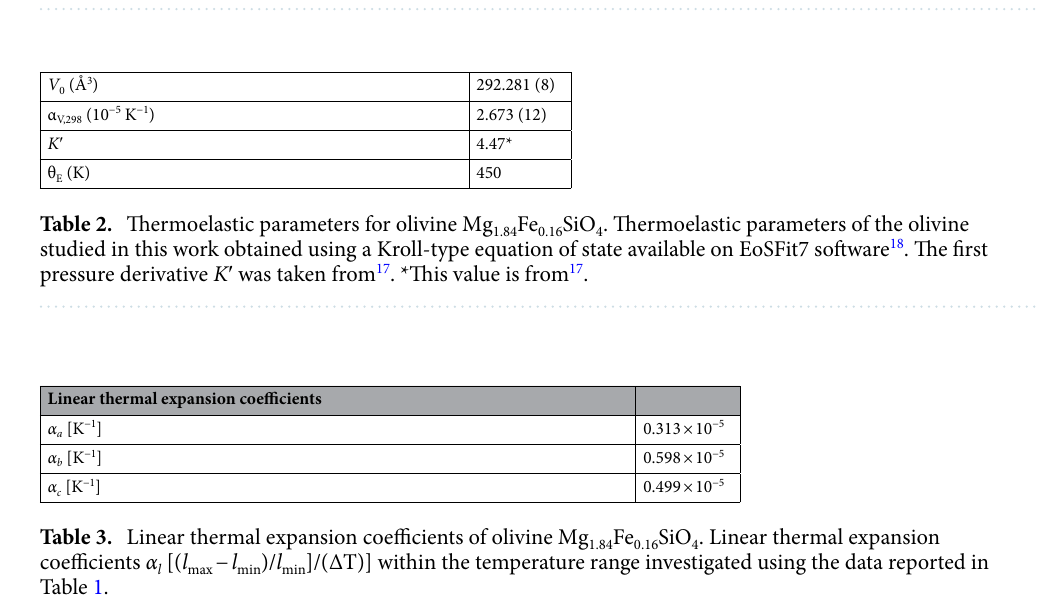
Figure 1. Evolution of the unit-cell volume of olivine as a function of temperature. The unit-cell volume of olivine with composition Mg 1.84 Fe 0.16 SiO 4 is plotted versus temperature between 20 and 773 K. Triangles are from 7 whereas circles correspond to the data collected in this study. The blue curve represents the fit of all data (see text for more details).